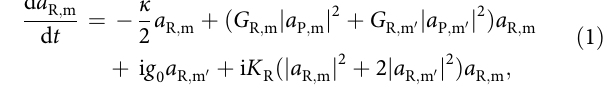
¼ G due to the balanced for- R ; m R ; m 0